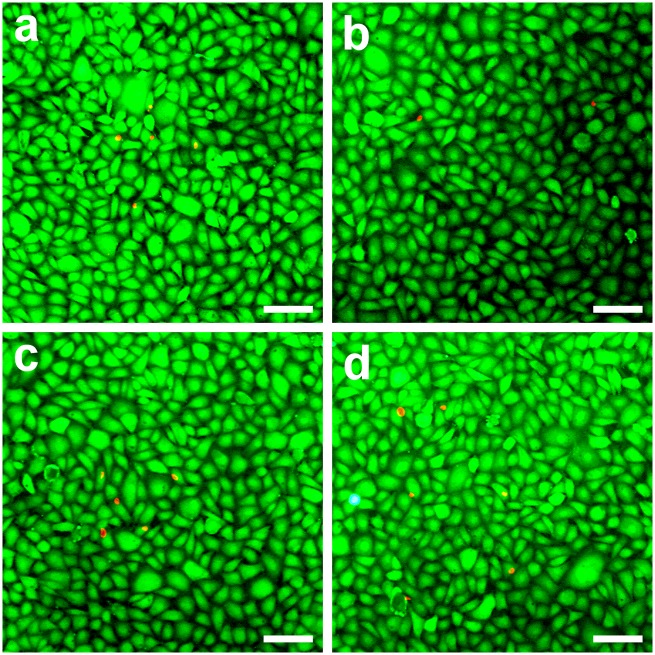
Cell viability of rabbit CEC cultures was determined by staining with Live/Dead Viability/Cytotoxicity Kit in which the live cells fluoresce green and dead cells fluoresce red.Fluorescence images of cells in (a) controls (without test materials) after 8 h of direct contact with different types of HA samples (b) AHA, (c) FHA, and (d) OHFA. Scale bars: 50 μm.